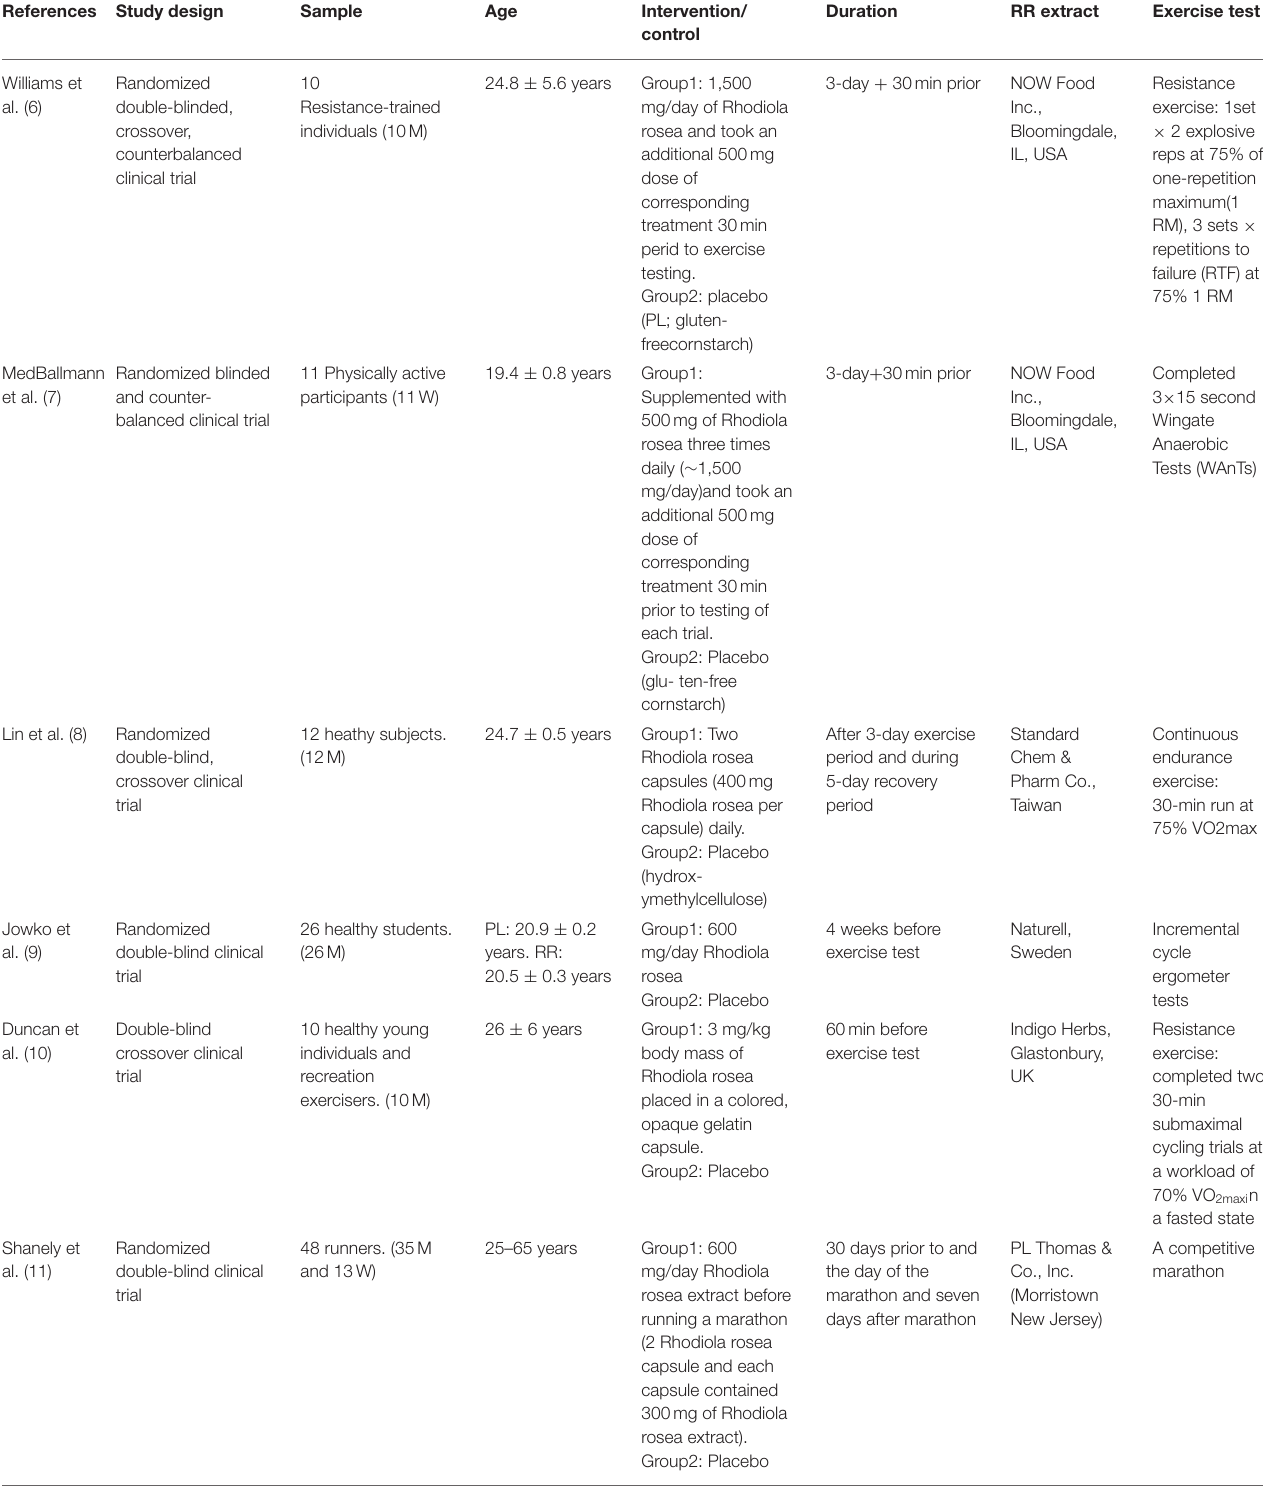
TABLE 1 | Characteristics of the studies